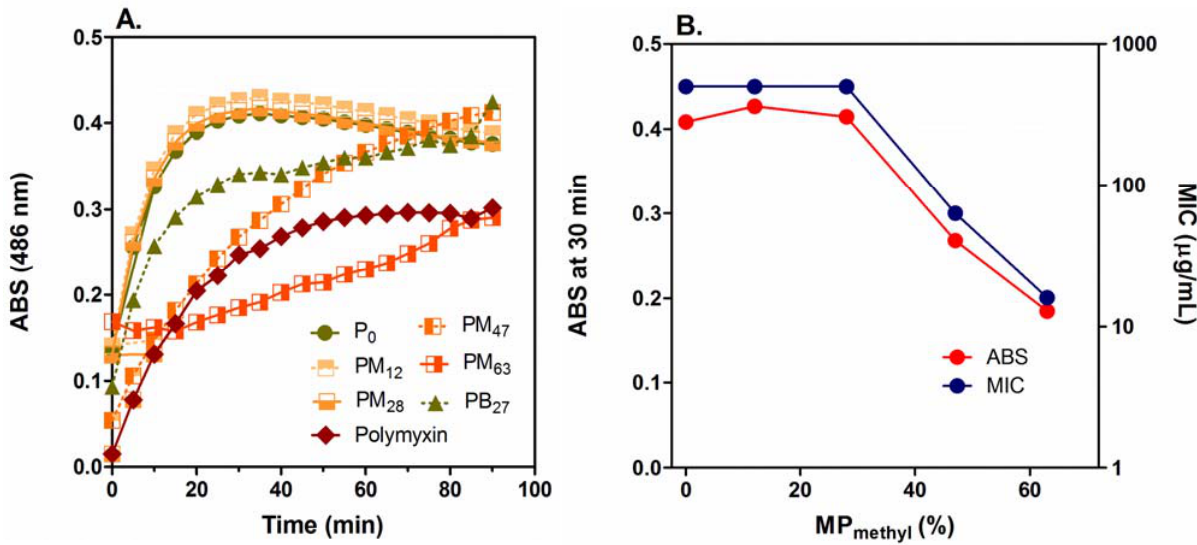
Figure 6. E. coli outer membrane permeabilization by PMAs (A) and the relationship between MIC and outer membrane (OM) permeabilization (B) . The polymer concentrations are 16 µg/mL except for PM (13 µg/mL). The polymyxin B concentration 63 is 1.1